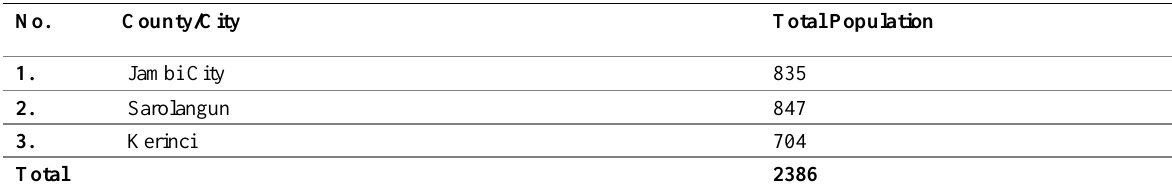
Table 1: IKM Populations in the Food and Beverage Sector